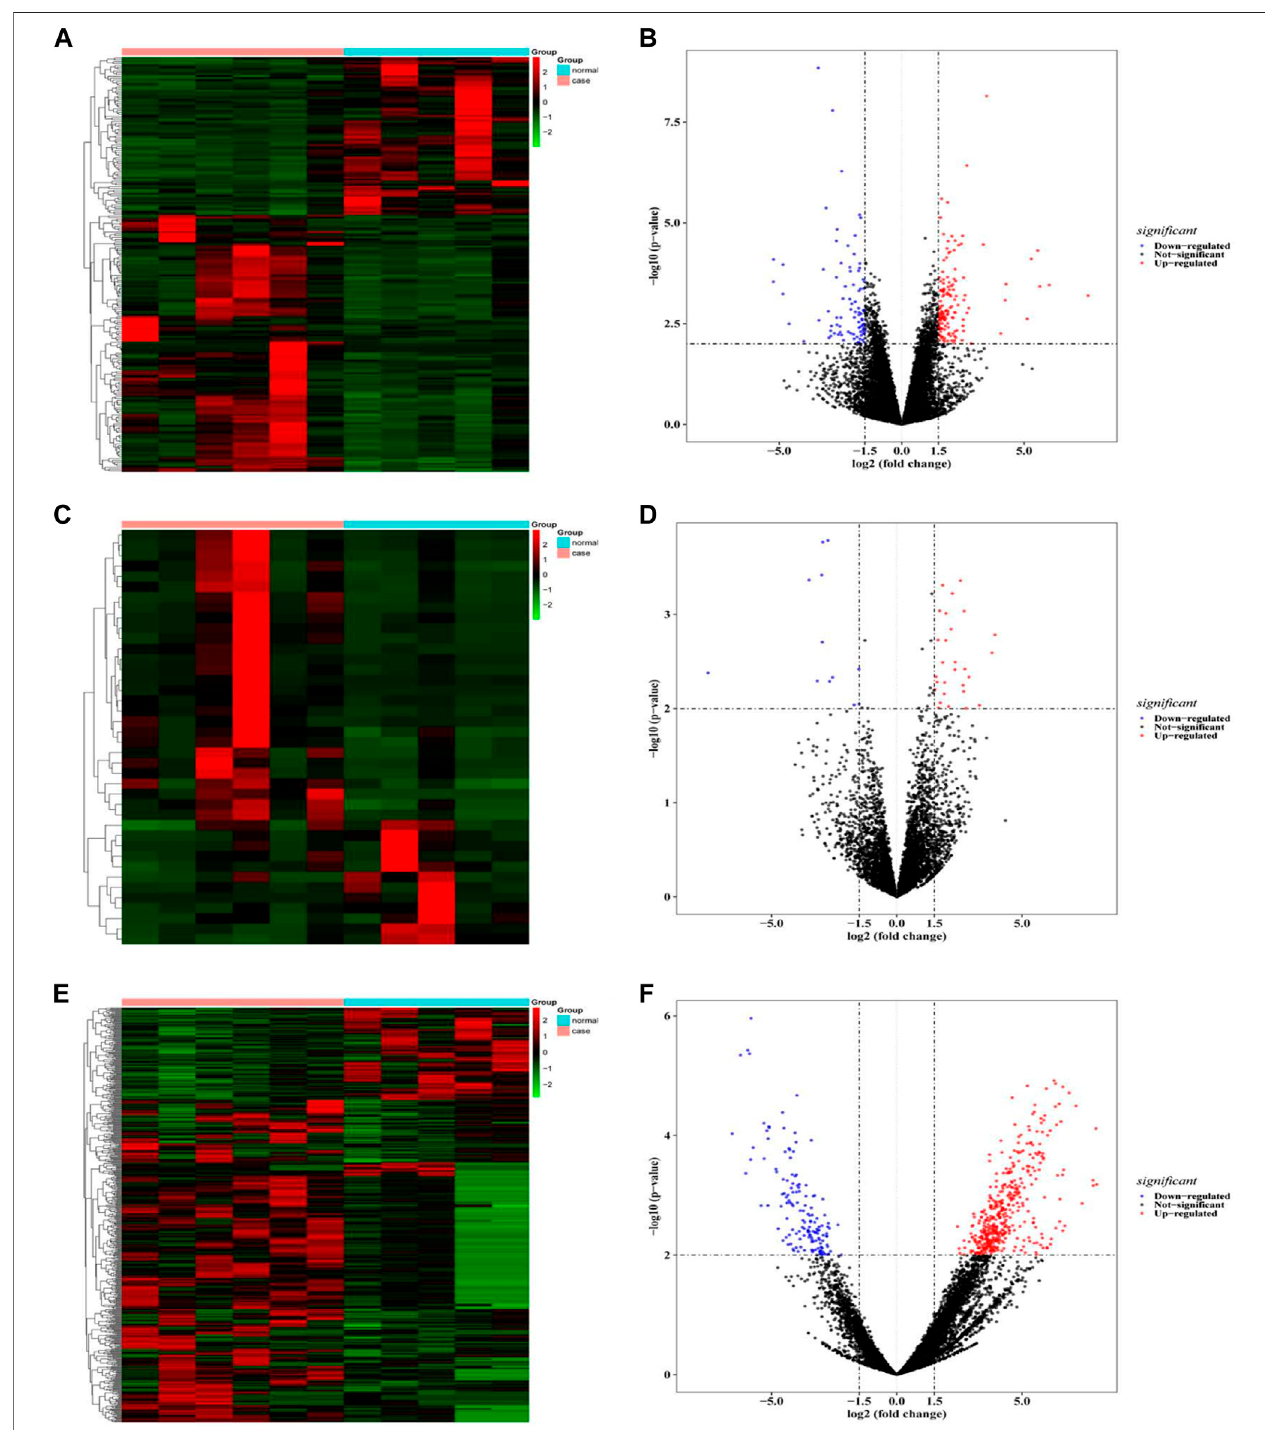
FIGURE 2| . (A,B) mRNA difference analysisheatmap and volcano map; (C,D) LncRNA differenceanalysisheat map and volcanomap; (E,F) CircRNA difference analysis heat map and volcano map.